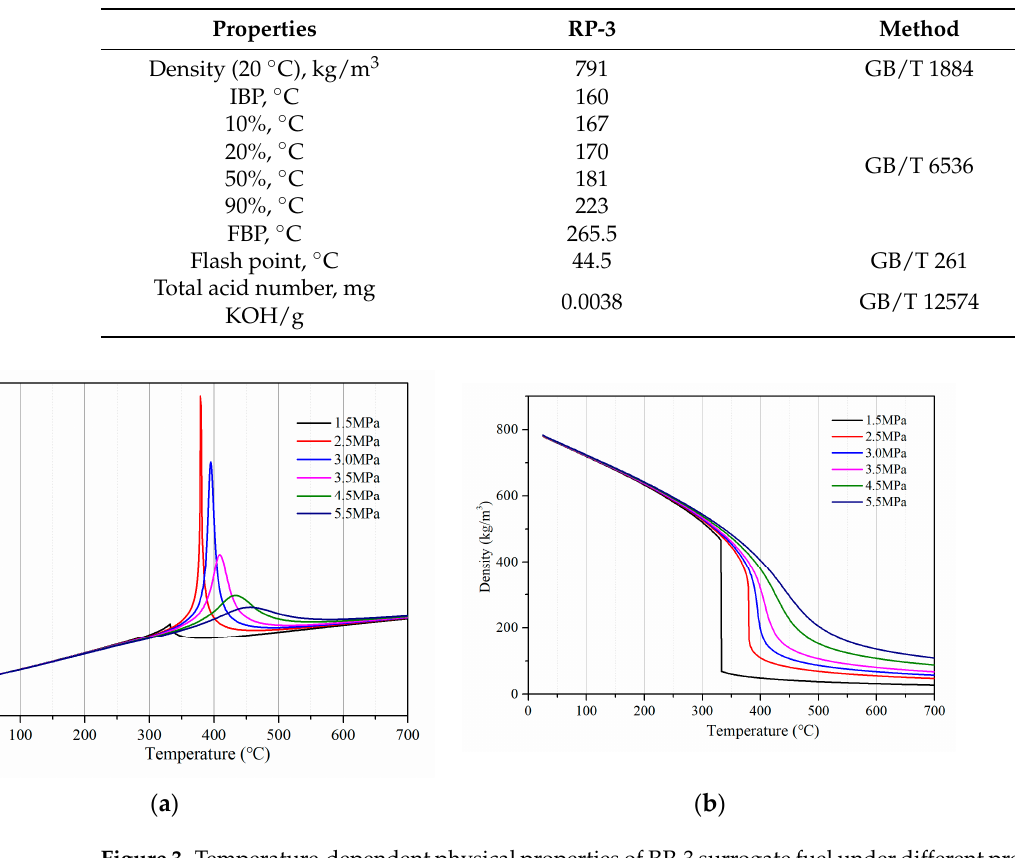
Table 2. Properties of aviation fuel RP-3.